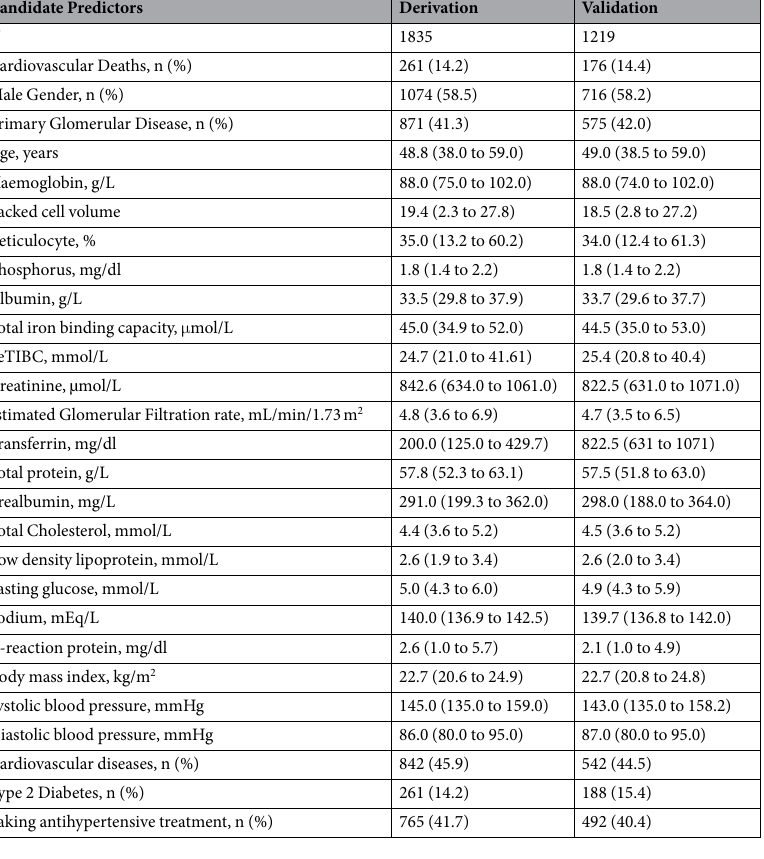
Table 1. Baseline Characteristics of study populations. Binary variable are displayed as numbers (percentage) and continuous variables are displayed as median